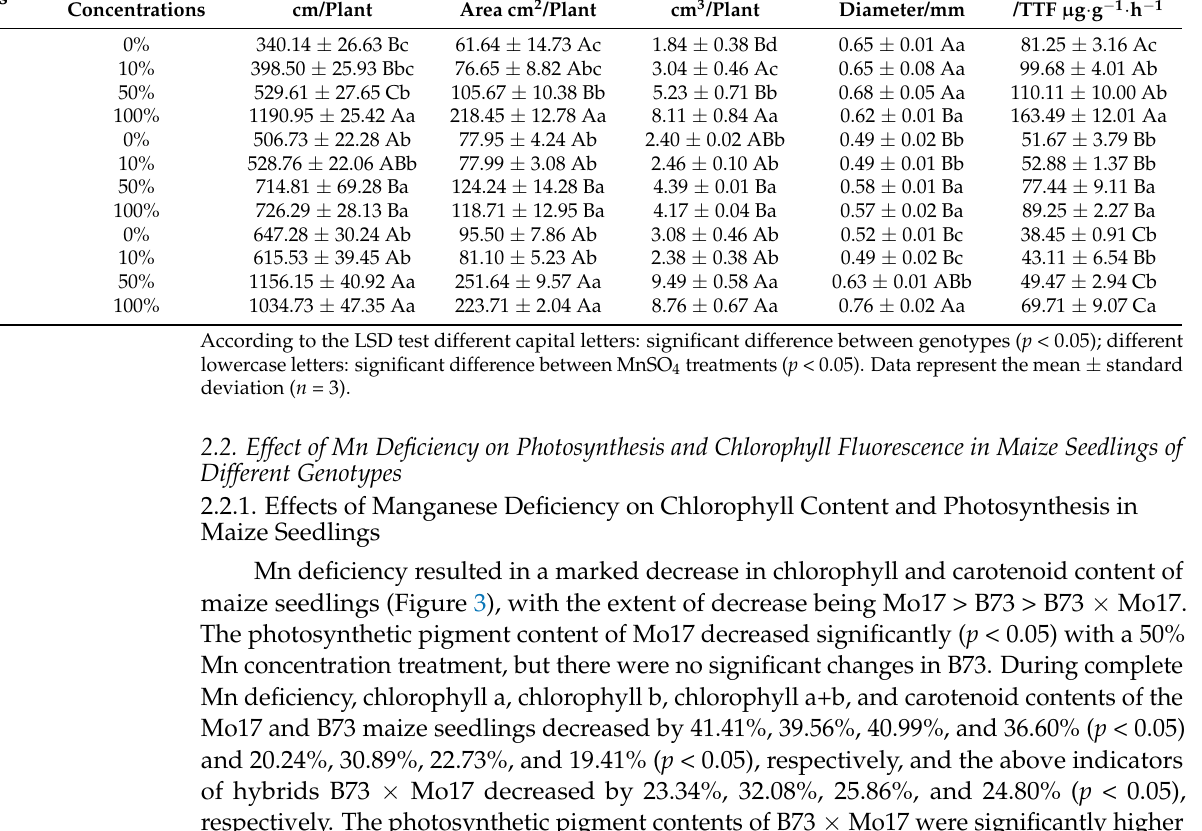
Figure 3. Effect of Mn deficiency on photosynthetic pigment contents and photosynthetic gas ex- change parameters of maize seedling leaves. Chlorophyll a ( A ), chlorophyll b ( B ), chlorophyll a+b ( C ), carotenoid contents ( D ), photosynthetic rate ( E ), transpiration rate ( F ), intercellular CO 2 ( G ), stomatal conductance ( H ). According to the LSD test, different capital letters: significant difference between varieties ( p < 0.05); different lowercase letters: significant difference between MnSO 4 treat- ments ( p < 0.05). Data are expressed as the mean of three replicates. The net photosynthetic rate (Pn), transpiration rate (Tr), and stomatal conductance (Gs) of maize seedling leaves significantly decreased, and the intercellular CO 2 concentra- tion (Ci) increased during Mn deficiency, with the greatest variations occurring in Mo17. During mild Mn deficiency, Mo17 was the first to demonstrate signs of Mn deficiency stress, and the changes in indicators all reached the significance level. Pn, E, and Gs of Mo17 and B73 maize seedlings decreased by 49.93%, 54.55%, and 57.47% ( p < 0.05) and 42.07%, 46.35%, and 45.89% ( p < 0.05), respectively, when completely deprived of Mn, while the Ci increased by 27.52% and 18.31%, respectively. Additionally, B73 significantly decreased in Tr and Gs only during complete Mn deficiency. The Pn, Tr, and Gs of the hybrid B73 × Mo17 reached superparental levels under Mn deficiency treatment. 2.2.2. Effect of Mn Deficiency on Chlorophyll Fluorescence in Maize Seedlings Changes in photosynthetic fluorescence parameters can respond to the inherent char- acteristics of photosynthesis when plants are stressed. Figure 4 shows that Fv/Fm, Y(II), ETR, NPQ, qP, and Y(NPQ) decreased significantly, and Y(NO) increased in maize seed- ling leaves during Mn deficiency. Mo17 responded most strongly to complete Mn defi- ciency; the same parameters decreased by 12.13%, 22.28%, 31.29%, 32.97%, 23.78%, and 44.30%, ( p < 0.05), respectively, while the Ci increased by 34.90%. B73 was relatively less affected, and the parameters decreased by 7.16%, 14.39%, 18.63%, 27.61%, 9.52%, and 19.89% ( p < 0.05), respectively, and Ci increased by 23.76%. The above indicators of hybrid